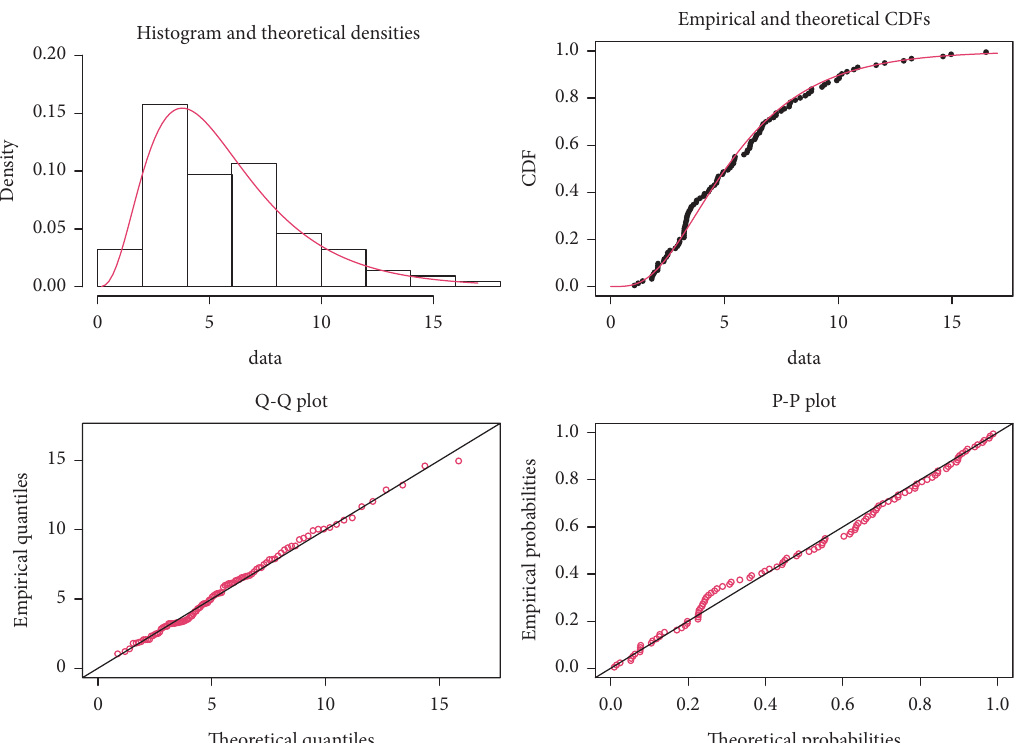
Figure 1: The empirical and theoretical PDFs, empirical and theoretical CDFs, Q-Q plots, and P-P plots for the EWD for COVID-19 mortality rate data. Table 7: Comparison of optimal parameters of the proposed MDSSP and SSP for EWD with δ � 1 . 5 , c � 1 . 5 at 50 th percentile. β t q / t 0